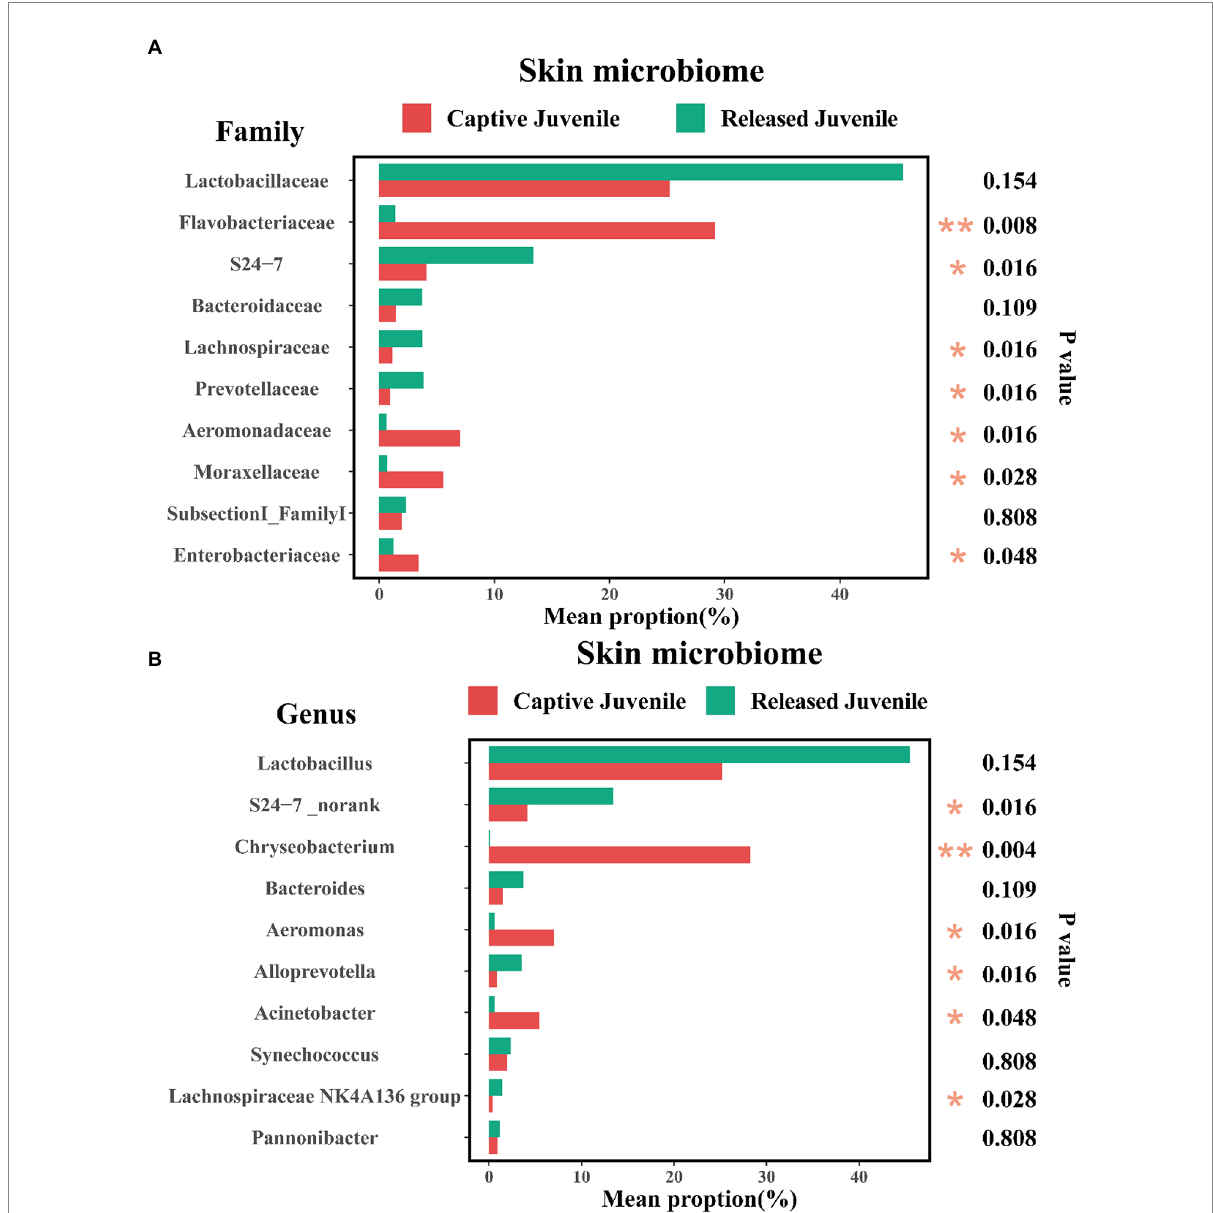
FIGURE 5 Variations of top 10 families (A) , and genera (B) , of skin microbiome between captive bred and released juveniles. A Mann–Whitney U test was used to evaluate the variation across two groups. Significance was set at the 0.05